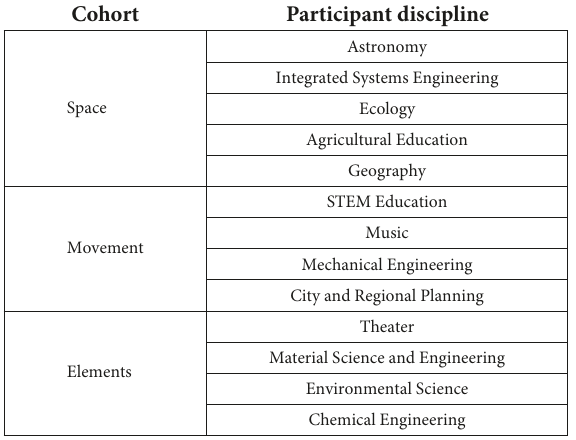
TABLE 1 Cohort participant